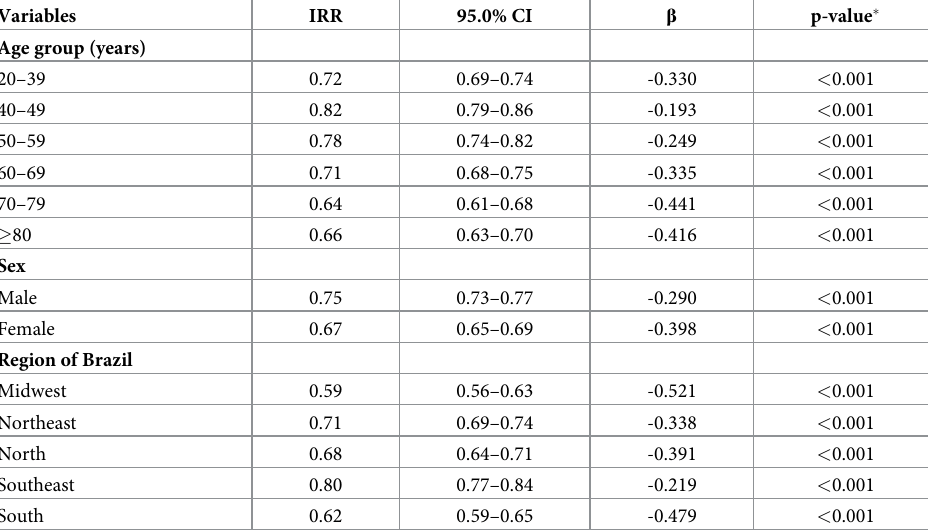
Table 10. Poisson multiple regression models of the impact of the coronavirus disease pandemic on the hospitali- zation rate for chronic respiratory diseases in Brazil according to subgroups by age group, sex, and region of Brazil.